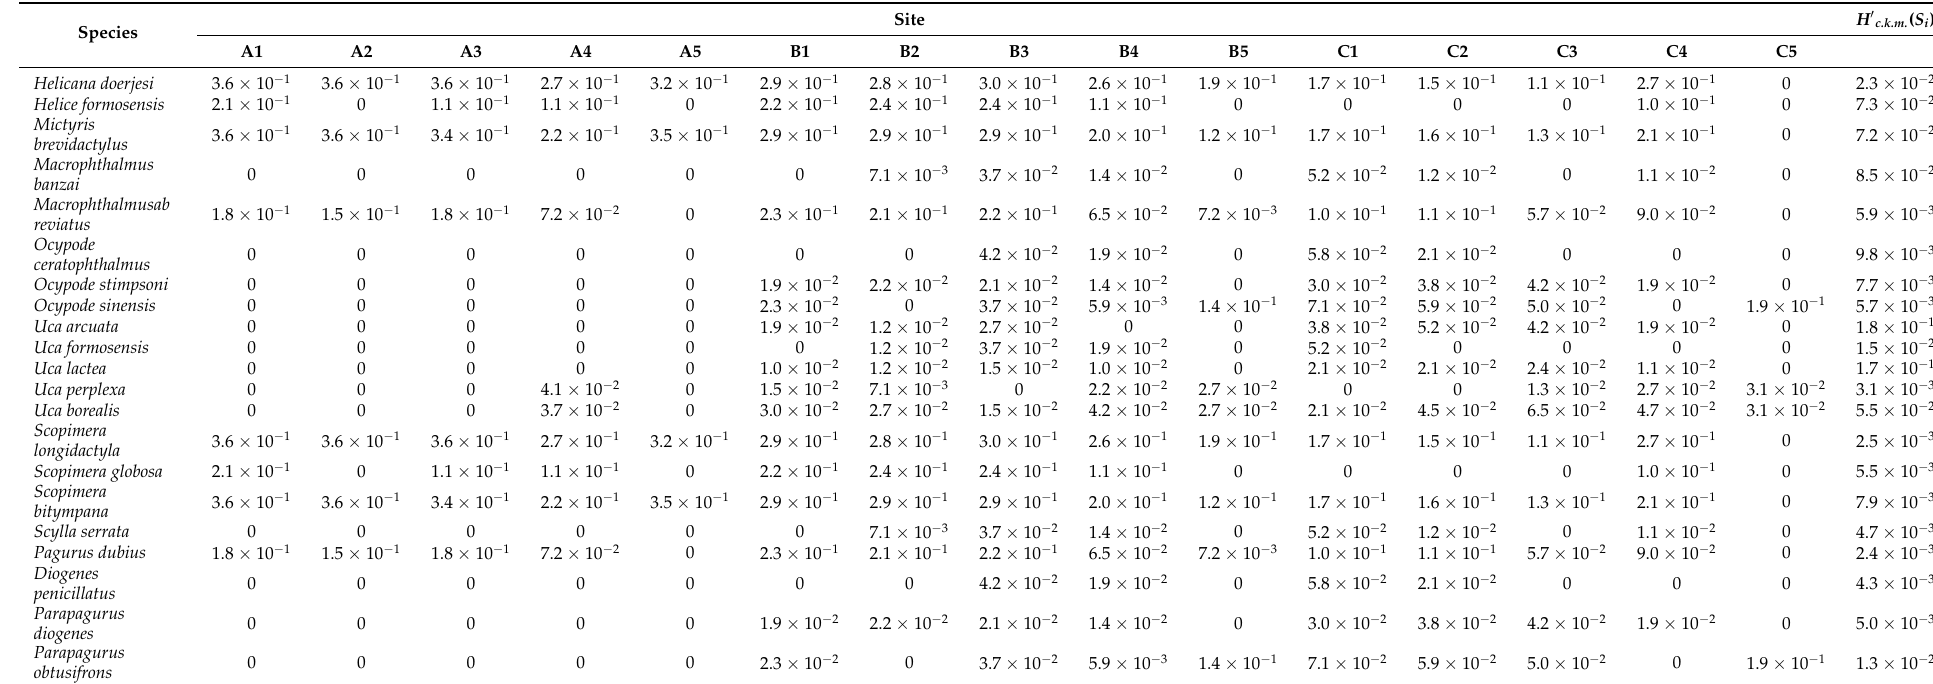
Table A3. Probabilities of the contribution of crab species to biodiversity ( H (cid:48) c.k.m. ) at different